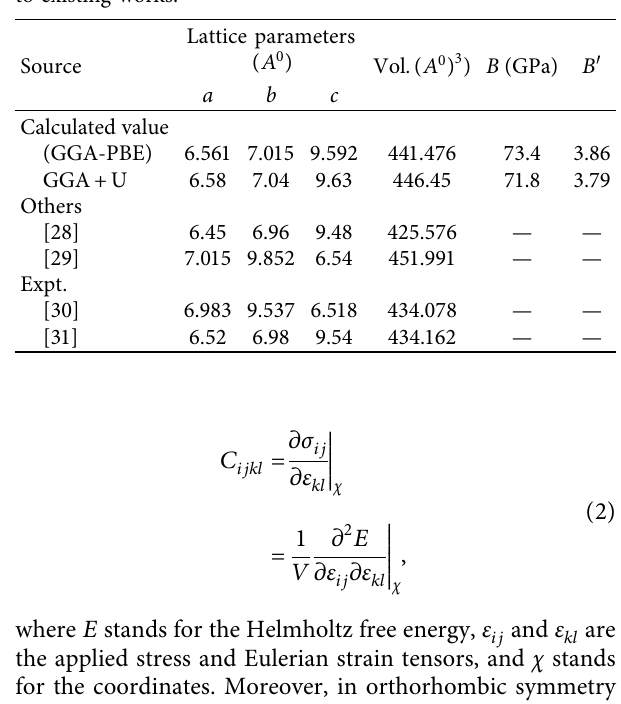
Table 1: Calculated values of equilibrium lattice constant, unit cell volume, bulk modulus, and its derivative of CaHfS 3 in comparison to existing